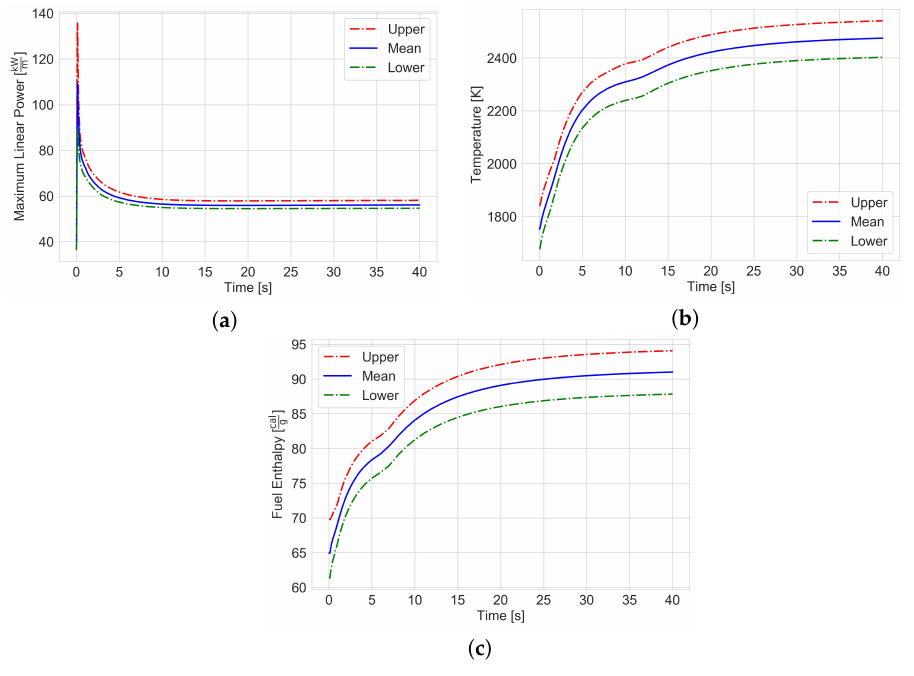
Figure 24. Temporal evolution of the ( a ) P max